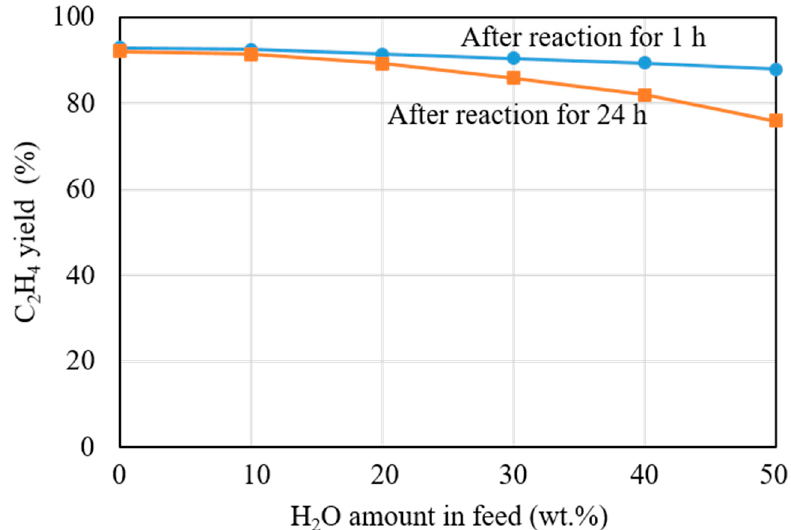
Figure 7. Influence of water amount in feed for the dehydration of ethanol over H-ZSM-5. Reaction conditions: catalyst: 2 g; liquid feed rate: 0.13 mL min − 1 ; Ar flow rate: 10 mL min − 1 ; reaction pressure